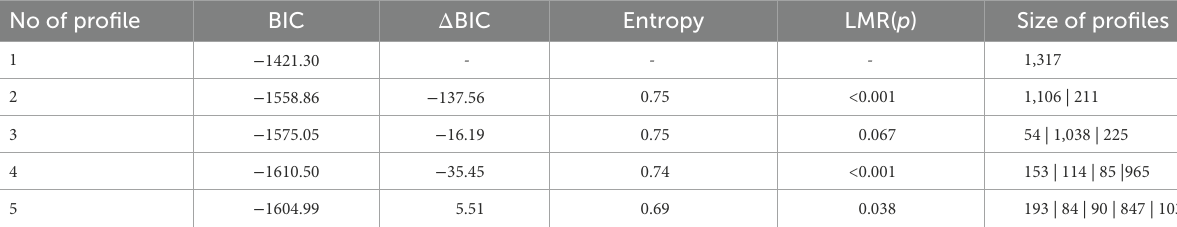
TABLE 3 Statistics for profile